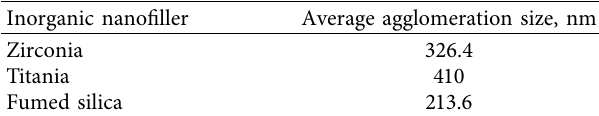
Figure 4: SEM images of (a) nanozirconia and (b) nanotitania. Table 5: Average agglomeration